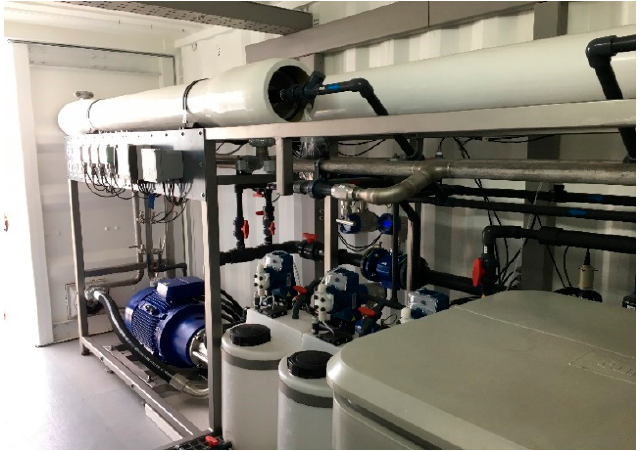
Figure 2. Interior view of the pilot plant used in the study.